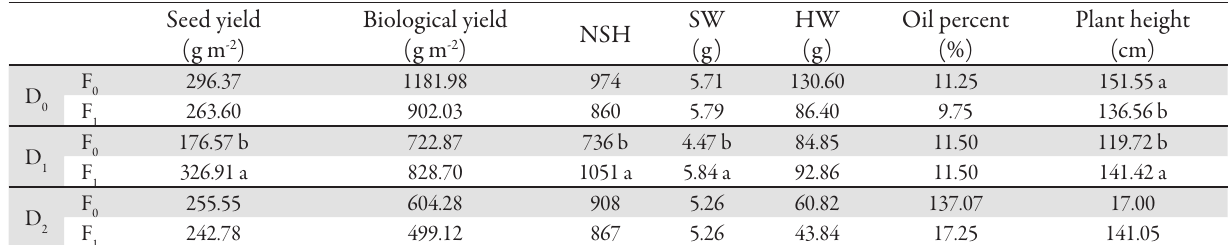
Tab. 2. Interaction effects of defoliation and Fe applications on oil percentage, biological and seed yield, yield components and plant height of sunflower